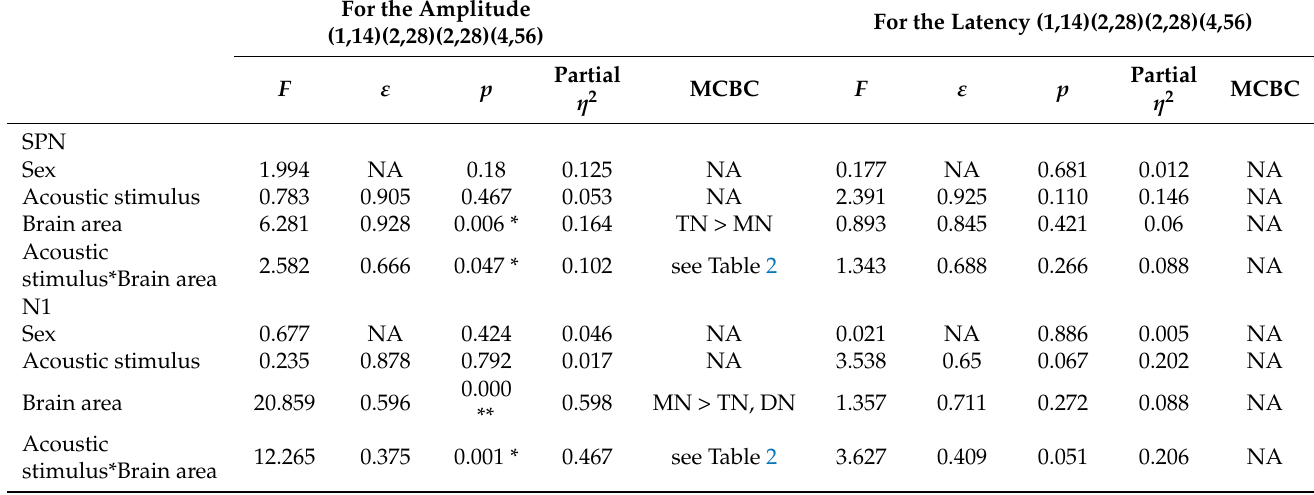
Table 1. Results of ANOVA for the amplitudes and latencies of SPN and N1 with respect to the three factors for the experiments recruiting voluntary attention.